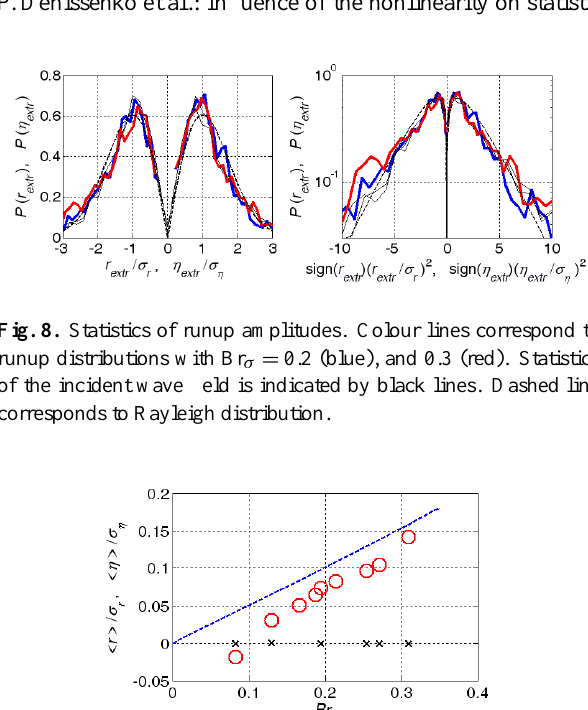
Fig. 11. Red lines correspond to runup statistics and black lines show distribution of the water elevation in the incident wave for Br σ = 0 . 3. The dashed blue lines represent the forecasted proba- bility density functions of wave runup calculated from Eq. (12) by substituting measured values for skewness and kurtosis instead of those predicted by Eq.